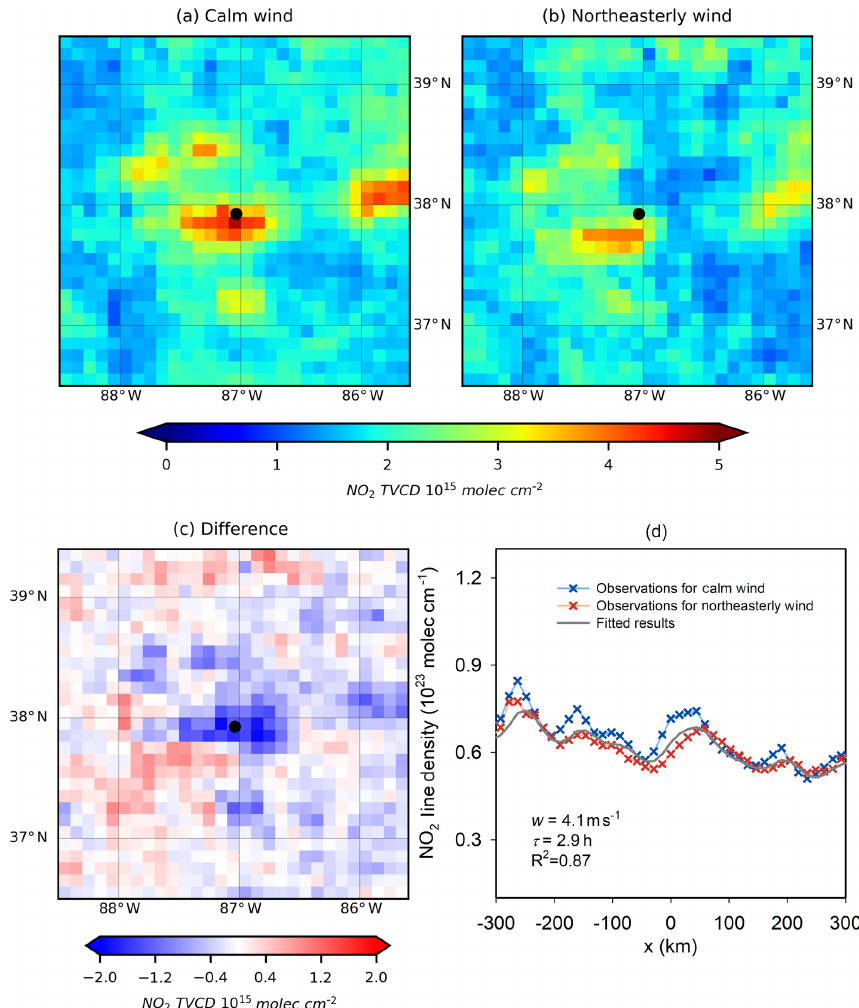
Figure 2. Mean OMI NO 2 tropospheric VCDs around the Rockport power plant (Indiana, USA) for (a) calm conditions, (b) northeasterly wind and (c) their difference (northeasterly minus calm) for the period of 2005–2017. The location of Rockport is labeled by a black dot. (d) NO 2 line densities around Rockport. Crosses are NO 2 line densities for calm (blue) and northeasterly winds (red) as function of the distance x to Rockport center. The grey line is the fitted results for NO 2 line densities for northeasterly winds. The numbers indicate the net mean wind velocities (windy minus calm) from MERRA-2 ( w ), the fitted lifetime ( τ ), and the coefficient of determination ( R 2 ) of the